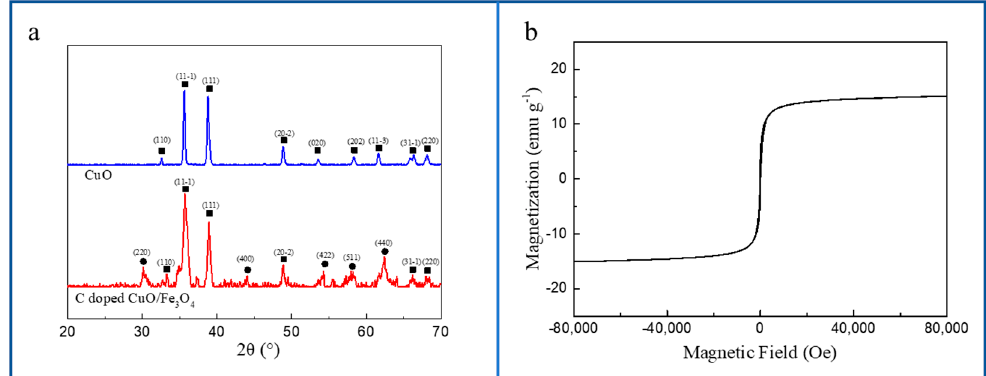
Figure 3. ( a ) Powder X-ray diffraction (PXRD) patterns of carbon-doped Fe 3 O 4 /CuO composite catalyst. ( b ) Magnetization curve at 300 K of carbon-doped Fe 3 O 4 /CuO composite catalyst.